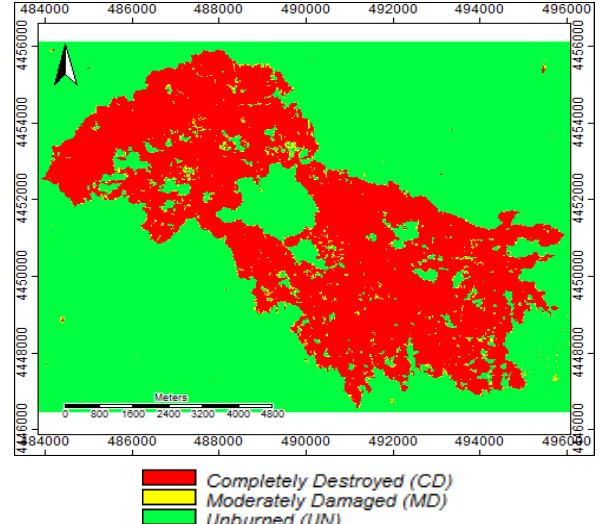
Figure 6. The result of SVM classification